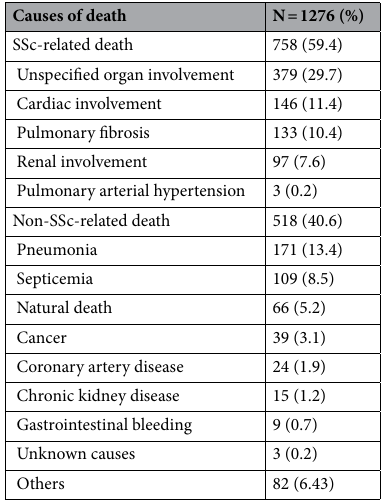
Table 1. Causes of death. SSc systemic sclerosis.